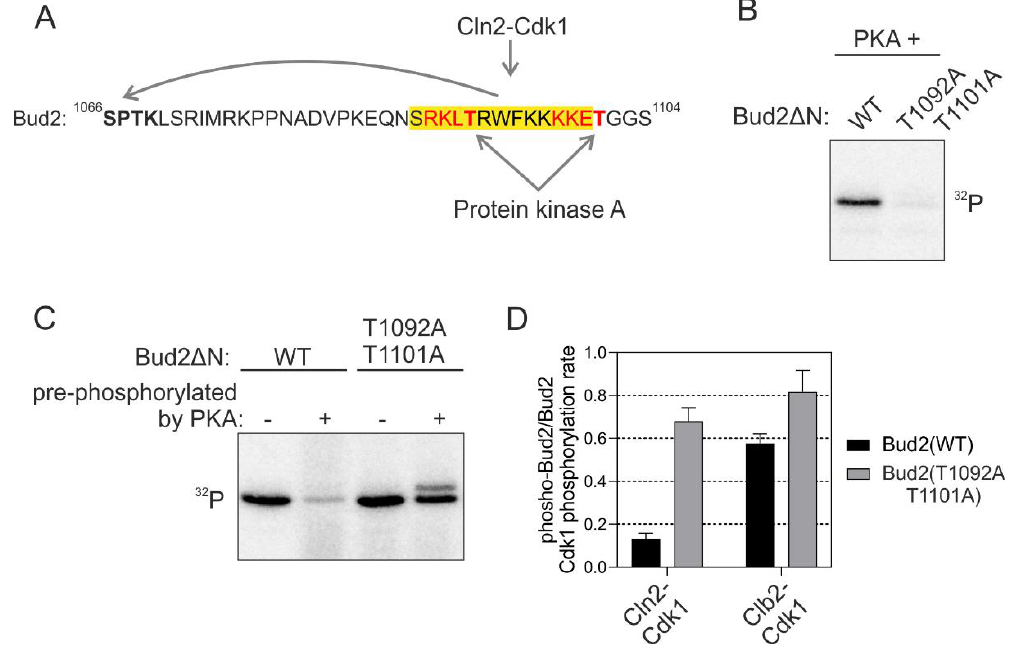
Figure 6. Phosphorylation adjacent to the K/R docking α -helix switches the docking off. ( A ) Scheme showing the sequence of Bud2 C terminus with two potential protein kinase A (PKA) phosphorylation sites in the K/R docking motif. ( B ) 32 P-autoradiographs showing the phosphorylation of T1092 and T1101 by PKA. ( C ) The C terminus of Bud2 was first phosphorylated by PKA without 32 P-ATP under conditions where Bud2 is expected to be fully phosphorylated at T1092 and T1101 by PKA, followed by removal of PKA and subsequent phosphorylation by Cln2-Cdk1 in the presence of 32 P-ATP. “ − “ indicates no pre-phosphorylation of Bud2 ∆ N, whereas “+” indicates that Bud2 ∆ N has been pre-phosphorylated by PKA. An autoradiograph showing the inhibition of Bud2 phosphorylation by Cln2-Cdk1 by pre-phosphorylation of the substrate with PKA. ( D ) The effect of Bud2 pre-phosphorylation by PKA on subsequent phosphorylation by Cln2- and Clb2-Cdk1. The error bars show standard deviation.